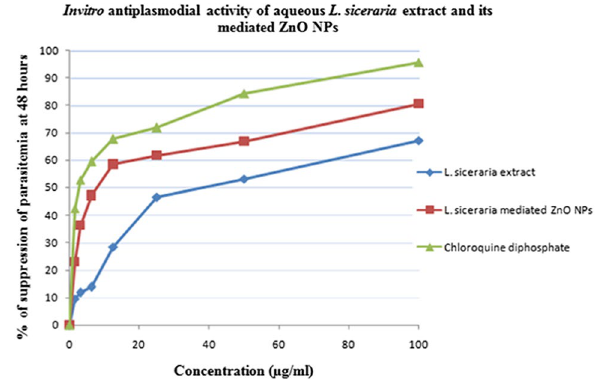
Figure 4. In vitro Antiplasmodial activity of aqueous L. siceraria extract and its mediated ZnO NPs.